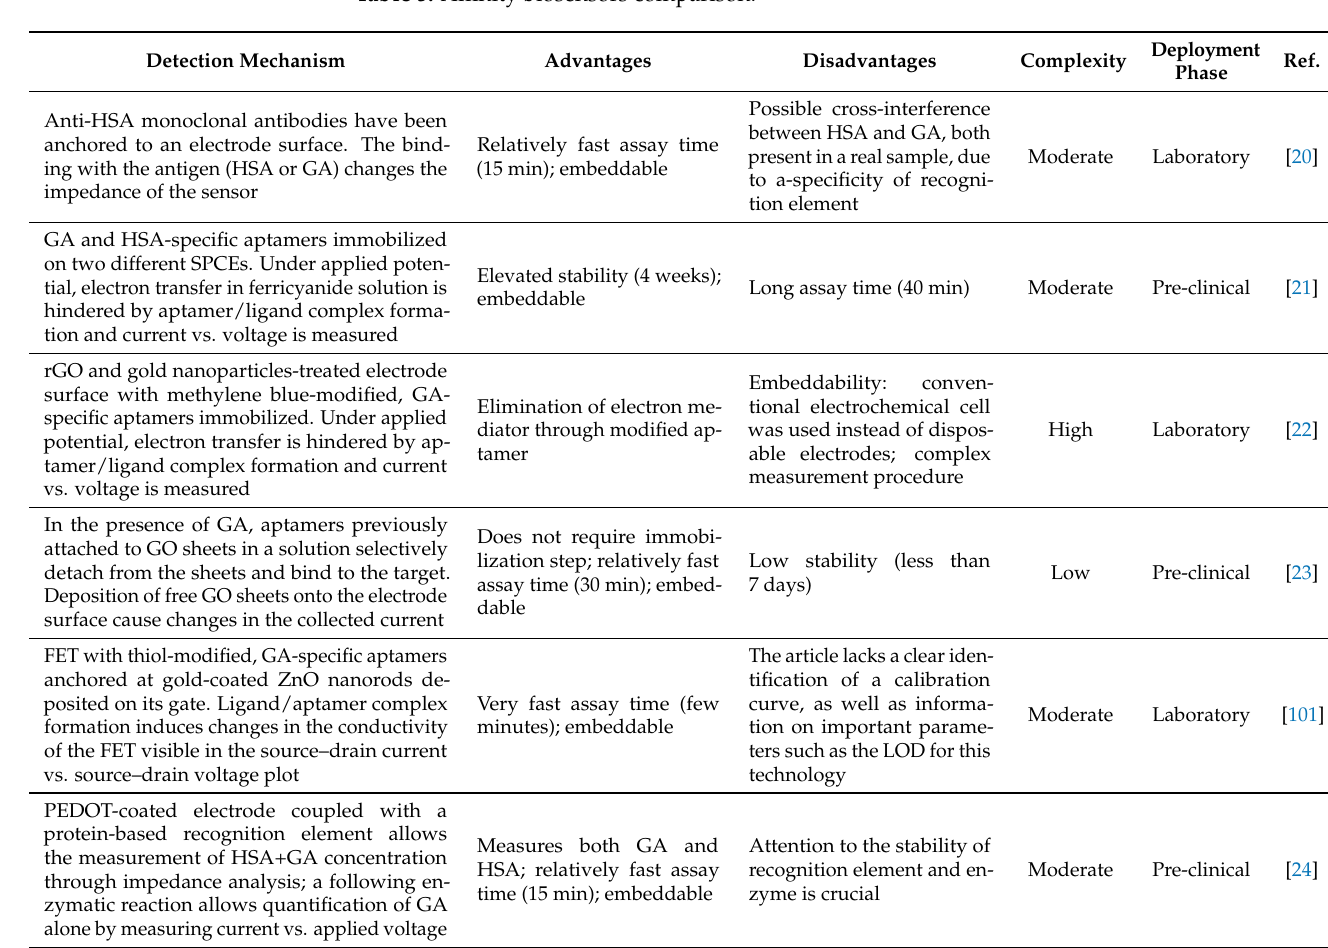
Table 5. Affinity biosensors